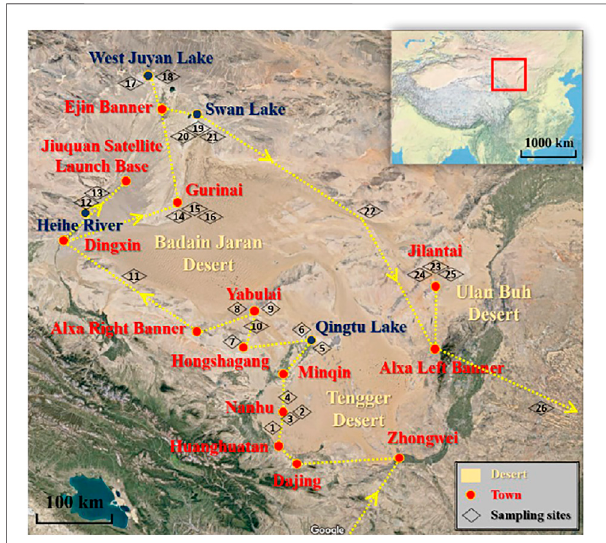
FIGURE 1 | Sampling route, sampling sites, and aqueous environments marked in